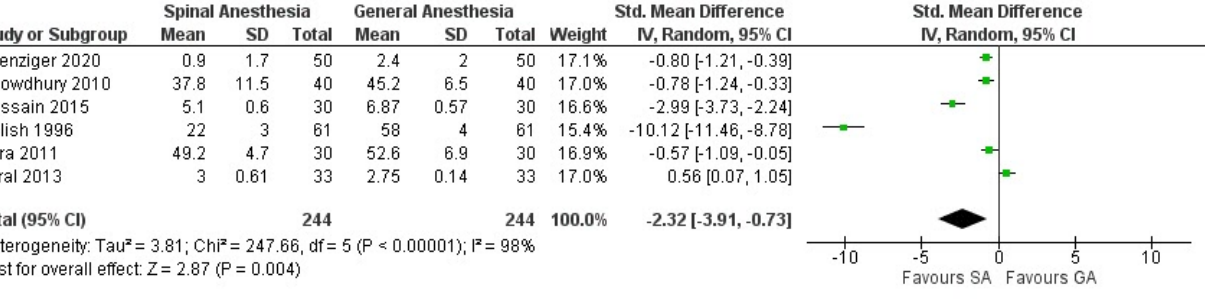
Figure 3. Forest plot of postoperative pain.